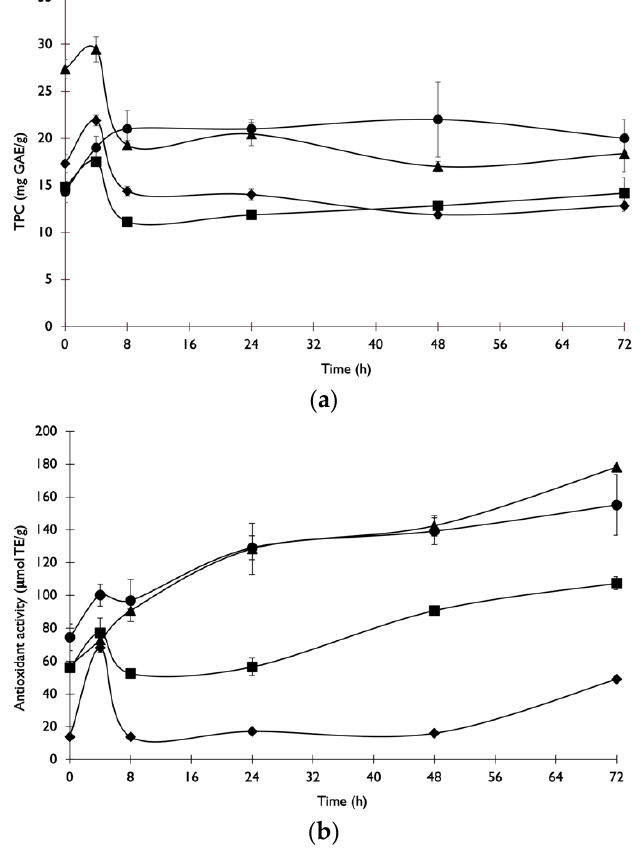
Figure 3. Variation of ( a ) phenolic compounds and ( b ) antioxidant activity after ET of untreated by- products, COP ( ● ), VTS ( ■ ), EOP ( ▲ ) and BSG ( ), using the enzymatic extract. ◆ Table 1. Sugars released by enzymatic treatment of